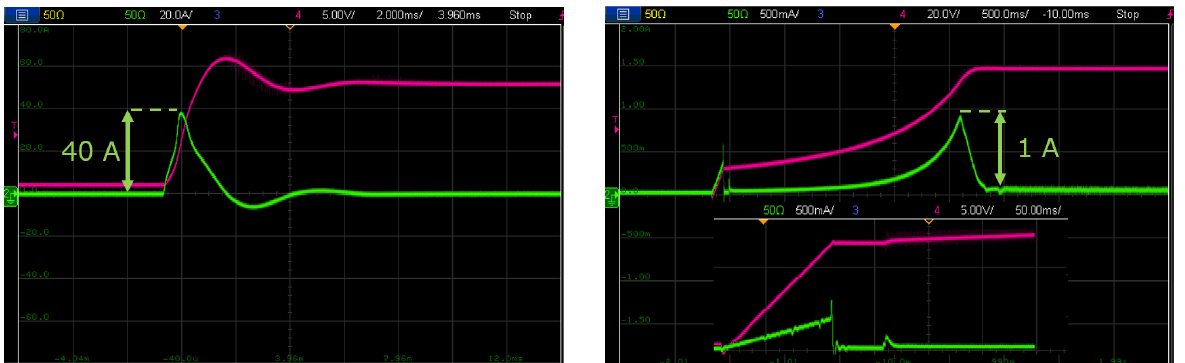
Figure 21. Initial inrush current ( in green ) and DC bus voltage ( in pink ) without and with the smooth start-up